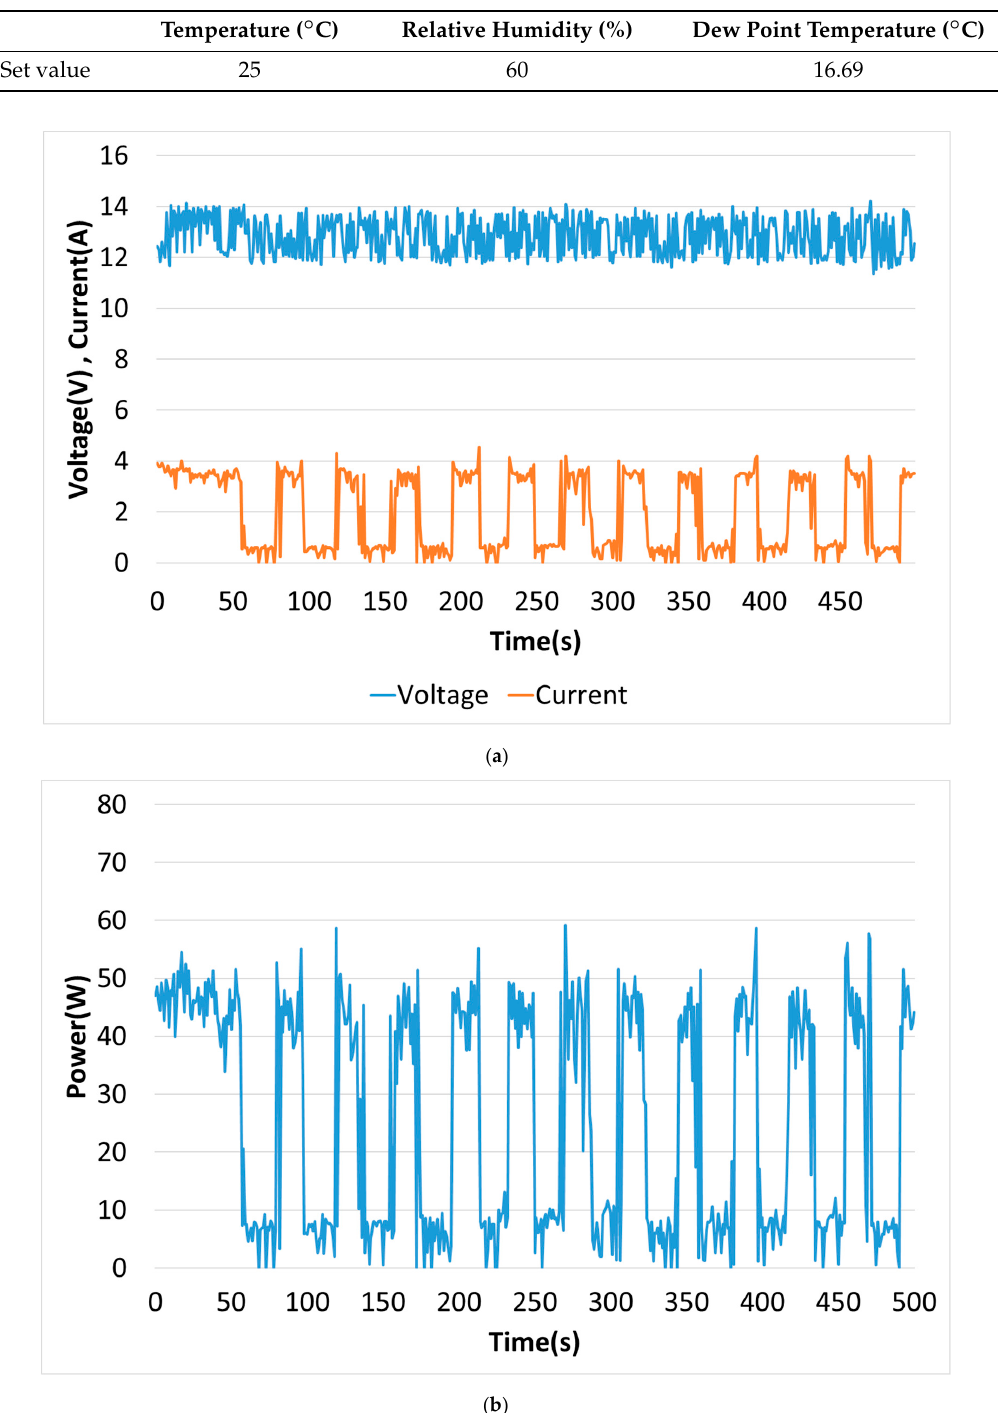
Table 6. Condition to analyze the control characteristics.